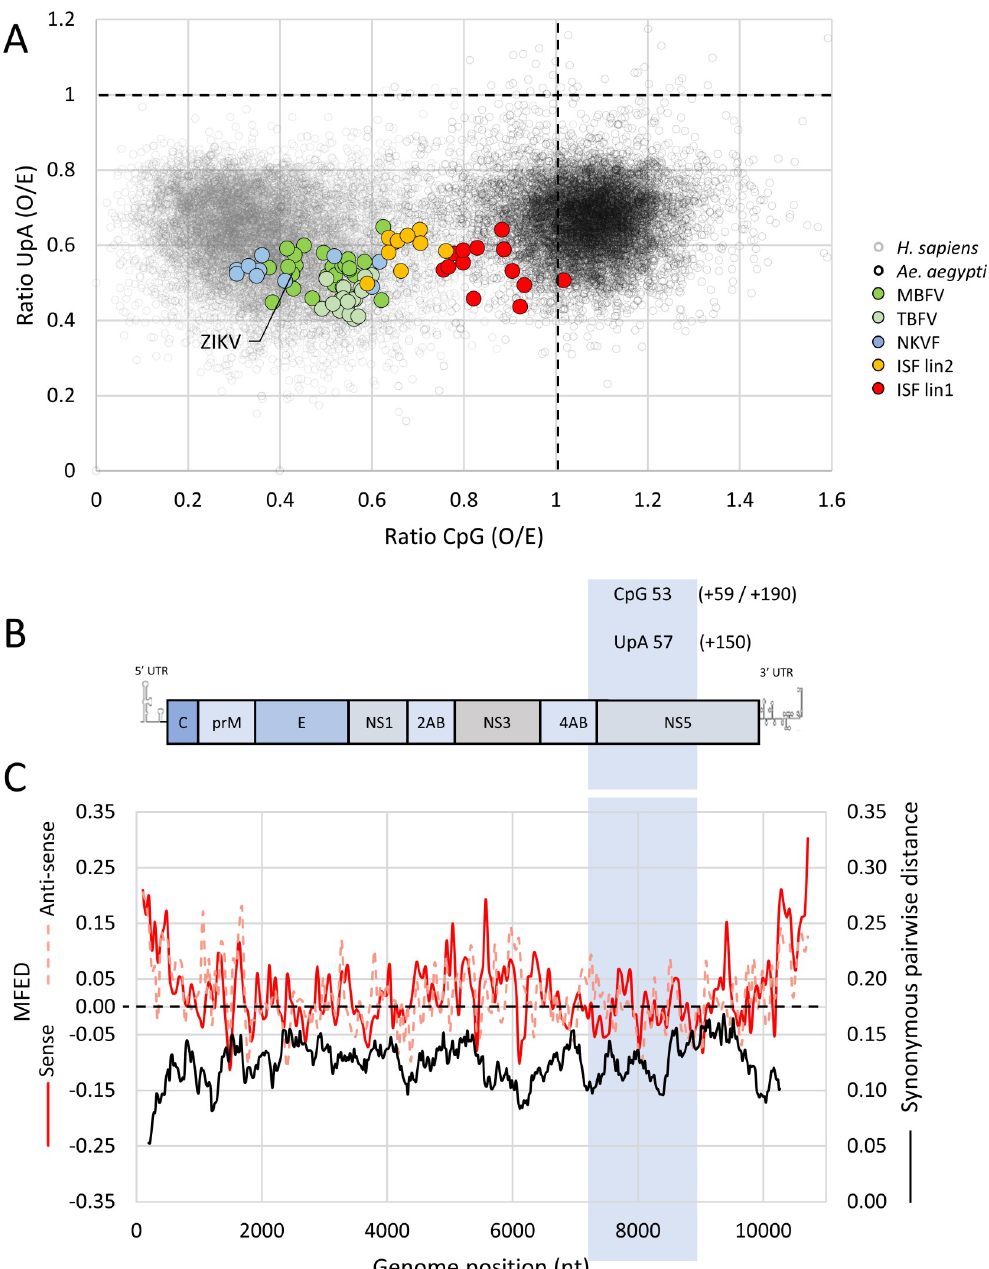
Fig 1. Flavivirus CpG and UpA dinucleotide usage, Zika virus genome organization, and the position of the mutated region. (A) Data points represent the ratio of CpG (x-axis) and UpA (y-axis) dinucleotides in individual RNA sequences. Small data points denote human mRNAs (gray) and mosquito mRNAs (black). Large data points represent full-length genome sequences of flavivirus species with MBFV (green), TBFV (light green), NKVF (blue), and the lineage 1 and 2 ISF (red and orange), respectively. The O/E ratio of 1.0 (dotted lines) is the mathematically expected frequency of occurrence if the RNA’s mononucleotides were randomly distributed. (B) Schematic representation of the ZIKV genome, with the mutated region boxed and displaying the number of CpG and UpA dinucleotides in wild-type ZIKV. Additional CpG and UpA dinucleotides of the CpG_1.0 (+59), CpG_max (+190), and UpA_max (+150) mutant viruses are listed in brackets. (C) MFED and synonymous pairwise distance (black line) were calculated for 19 ZIKV isolates that were > 1% dissimilar in nucleotide sequences using a fragment size of 200 with 48 nucleotide increments for MFED and sliding window of 21 codons for synonymous pairwise distance as used